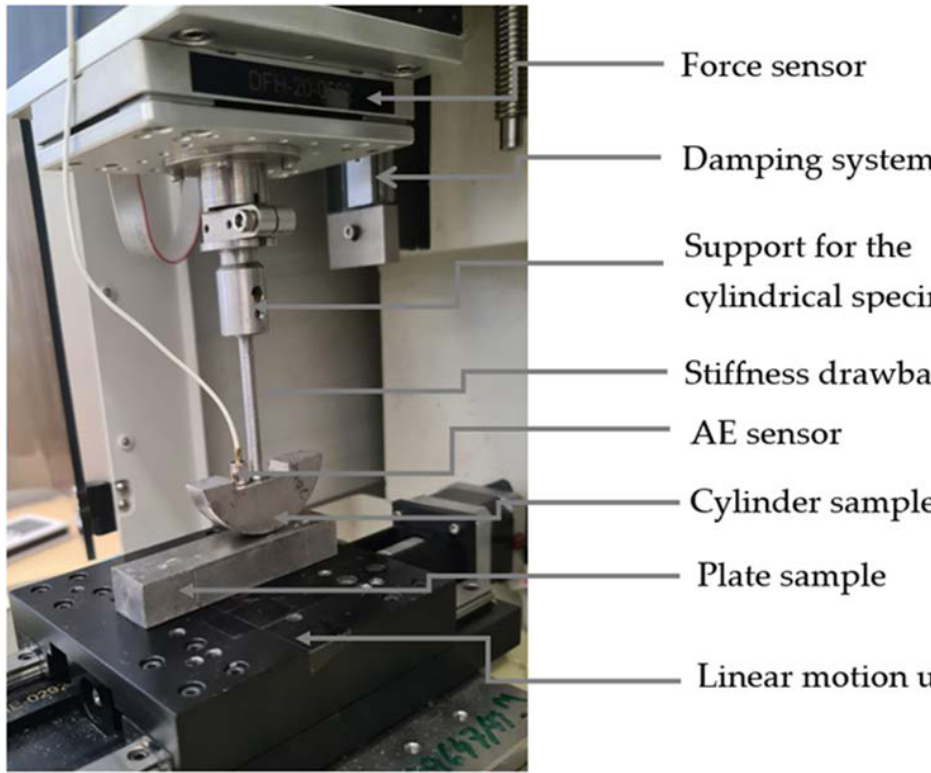
Figure 2. Tribometer to study the phenomenon of stick–slip.